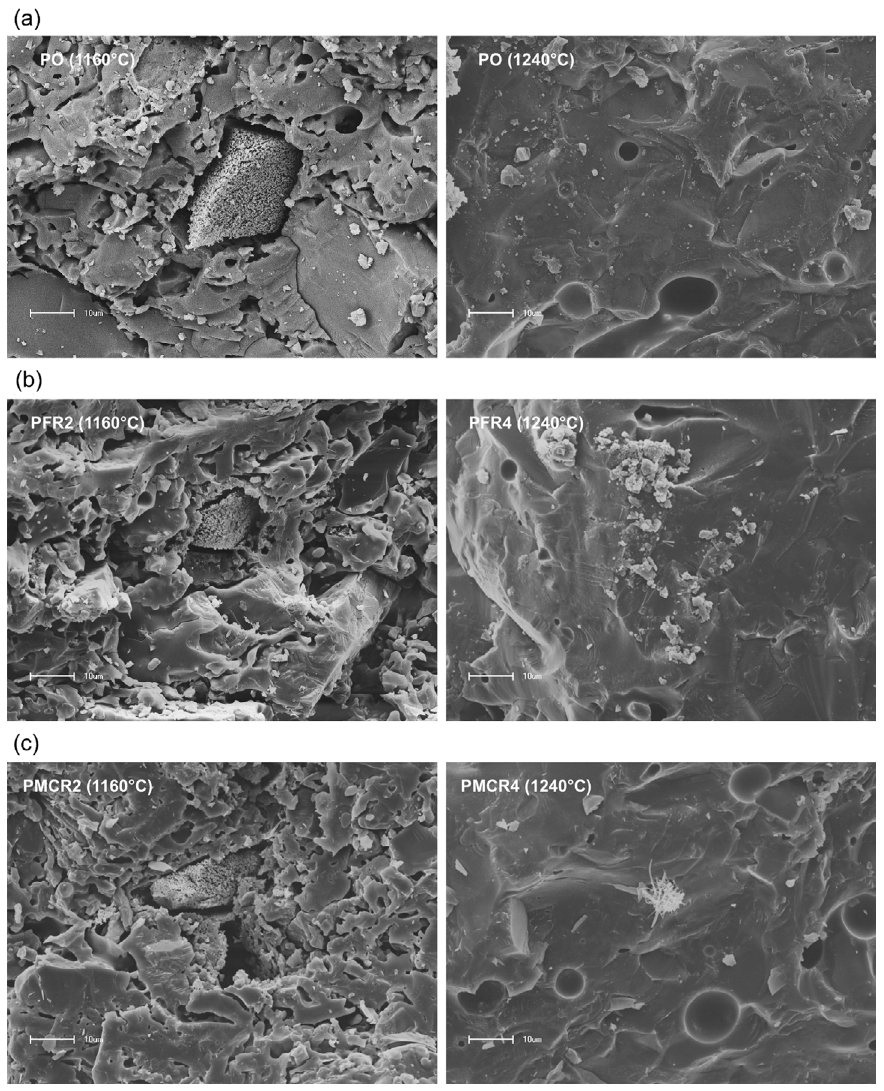
Figure 8. SEM micrographs of the fracture surface of pieces produced from: (a) ceramic mass for porcelain tile (PO); (b) composition with 9 wt.% of fine quartzite residue (PFR2, PFR4); (c) composition with 9 wt.% of milled coarse quartzite residue (PMCR2, PMCR4); sintered at 1160 and